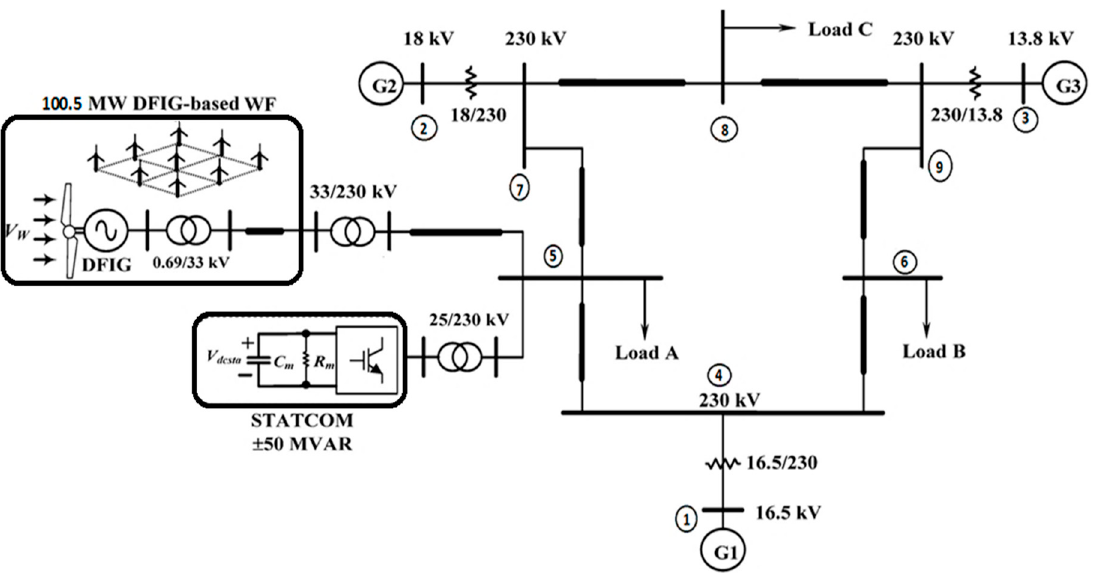
Figure 2. Double-fed induction generator (DFIG) wind turbine. 2.3. Wind Turbine and DFIG Modeling Wind turbine (WT) mechanical power generation is given as: 𝑃 (cid:3040) = (cid:2869) (cid:2870) 𝜌𝛢𝑐 (cid:3043) (cid:4666)𝜆, 𝛽(cid:4667)𝑣 (cid:3050)(cid:3036)(cid:3041)(cid:3031)(cid:2871) .